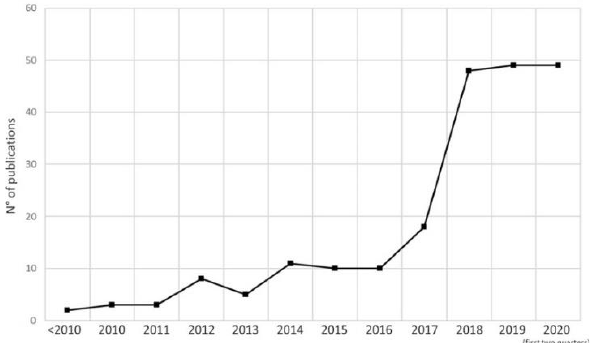
Figure 1. Number of publications on the topic of in situ sensing and/or in situ monitoring of powder bed fusion processes [3].